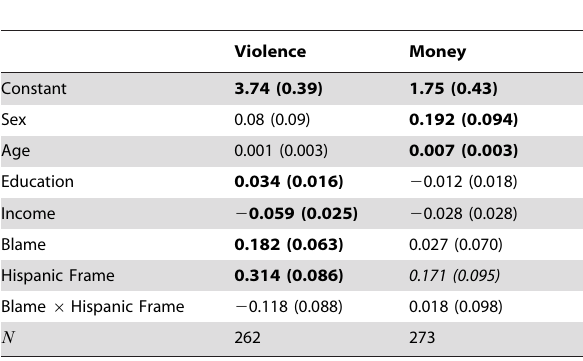
Table 4. The Effects of Blame and Race on Stereotype- Consistent